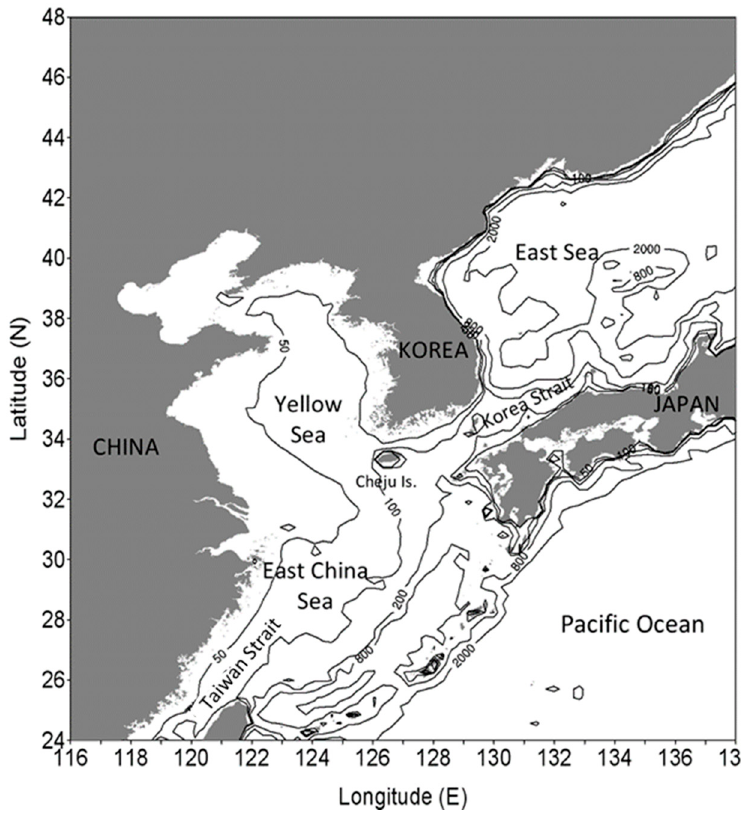
Figure 1. Geophysical configuration of the Yellow Sea and the East China Sea.